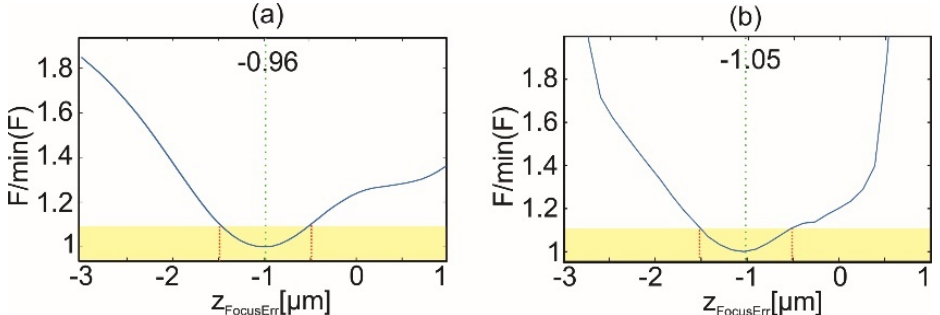
Figure 9. The focus measurement for: ( a ) equally angle spaced strategy, and ( b ) geometrically frequency spaced strategy.